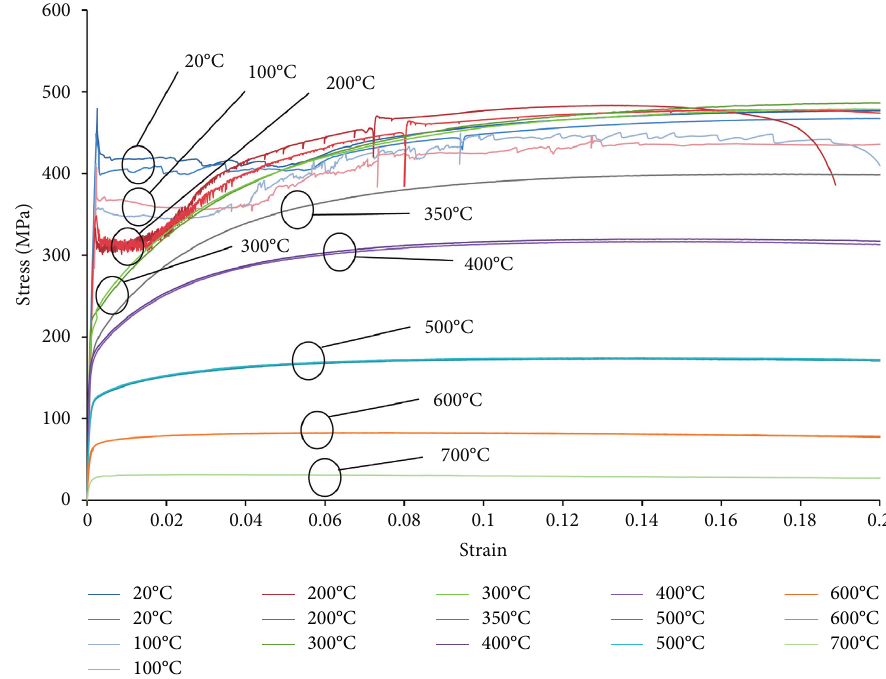
Figure 13: Stress-strain curves of S350 steels at different temperatures.